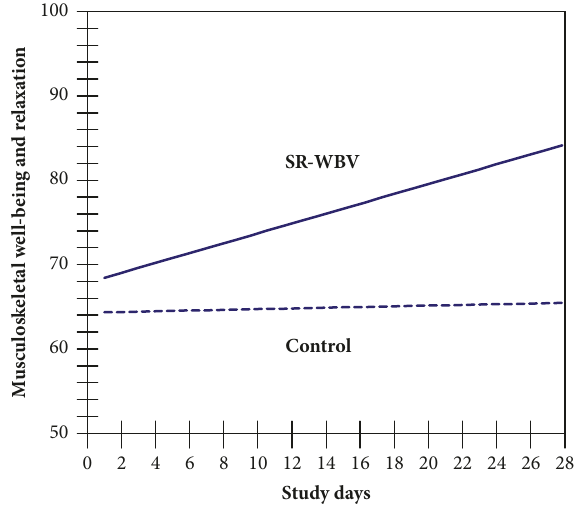
Figure 3: Effect of SR-WBV condition on daily surefootedness and sense of balance across 28-day study period. Figure 4: Effect of SR-WBV condition on daily musculoskeletal well-being and muscle relaxation across 28-day study period.